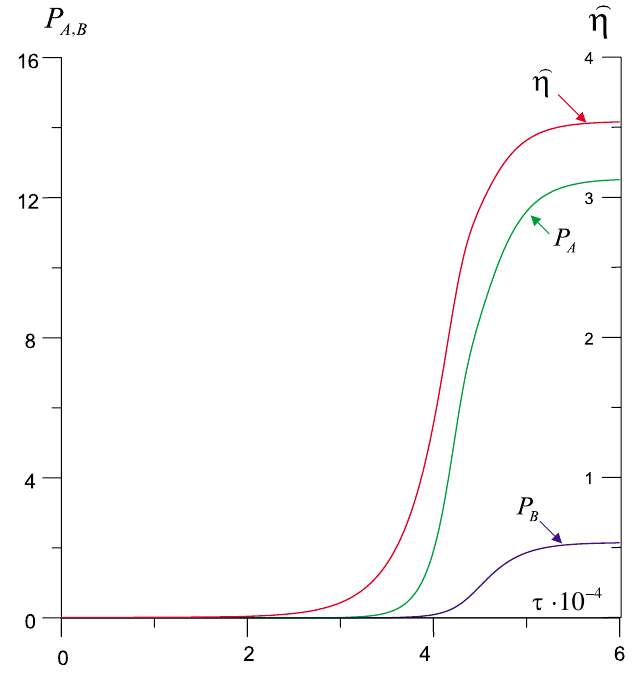
FIG. 4. (Color) Time dependences of the normalized electron efficiency ^ , (red curve), radiation losses associated with prop- (green curve), and trapped wave P agating wave P A (cid:1) 2 : 5 , (cid:28) (cid:10) 3 , (cid:16) (cid:10) (cid:6) 0 : 6 . curve) for L opt